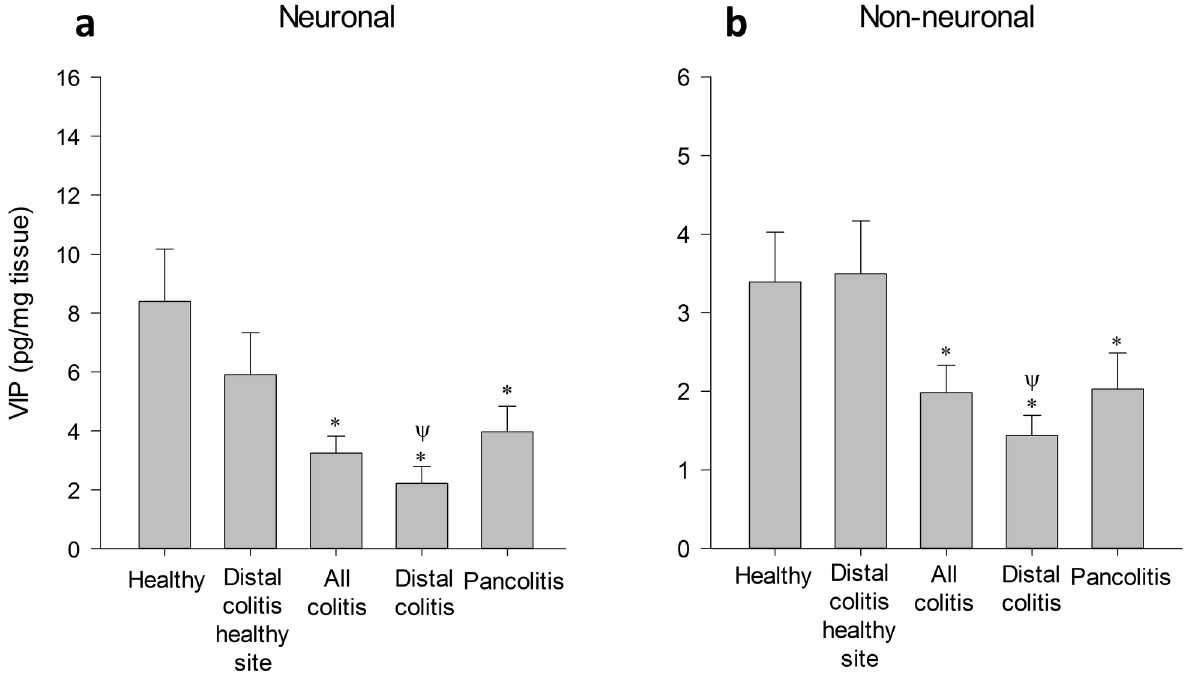
Fig 3. Changes in VIP levels (mean ± SEM). a: Neuronaland b: Non-neuronal levels of VIP are demonstrated. * P < 0.05,comparedto healthy tissue. Ψ P < 0.05,compared to distal colitis healthy site.